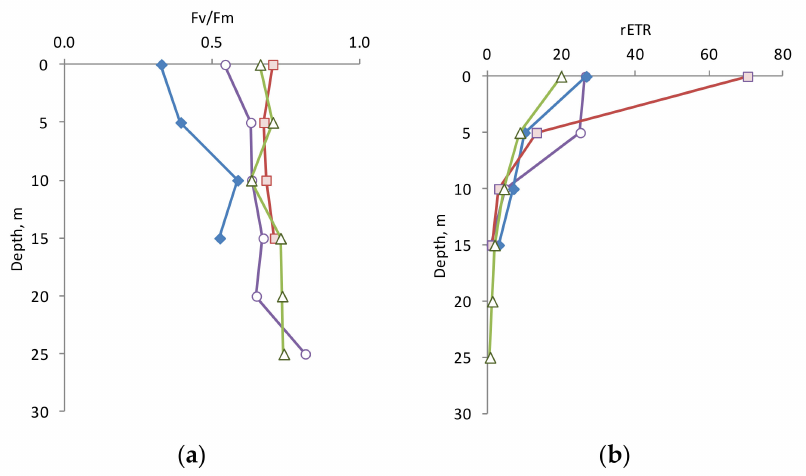
Figure 3. Vertical distribution of phytoplankton state parameters: ( a ) maximum quantum efficiency of PSII, F v /F m , ( b ) relative electron transport rate, rETR for April (circles), June (rhombus), October (squares), and November